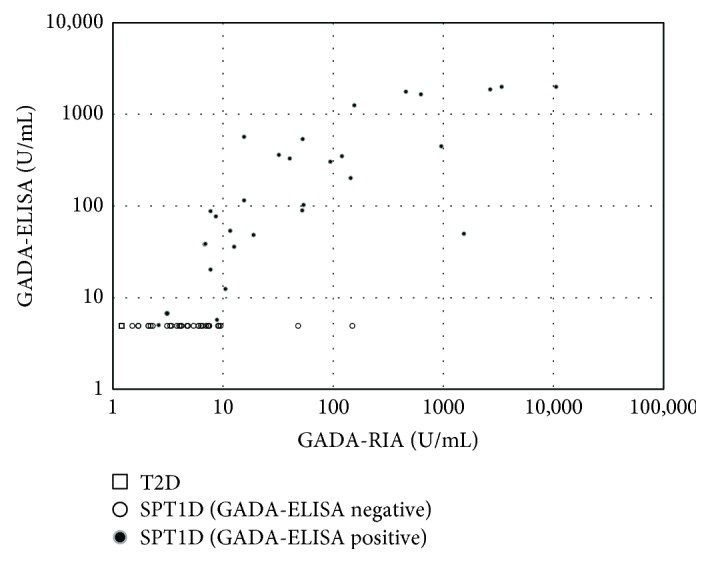
Correlation between GADA-RIA and GADA-ELISA. Dot plots show a significant correlation between GADA-RIA and GADA-ELISA titers in all patients (ρ = 0.730, P < 0.001), in GADA-RIA-positive patients with SPT1D (ρ = 0.778, P < 0.001), and in GADA-ELISA-positive patients with SPT1D (ρ = 0.819, P < 0.001).